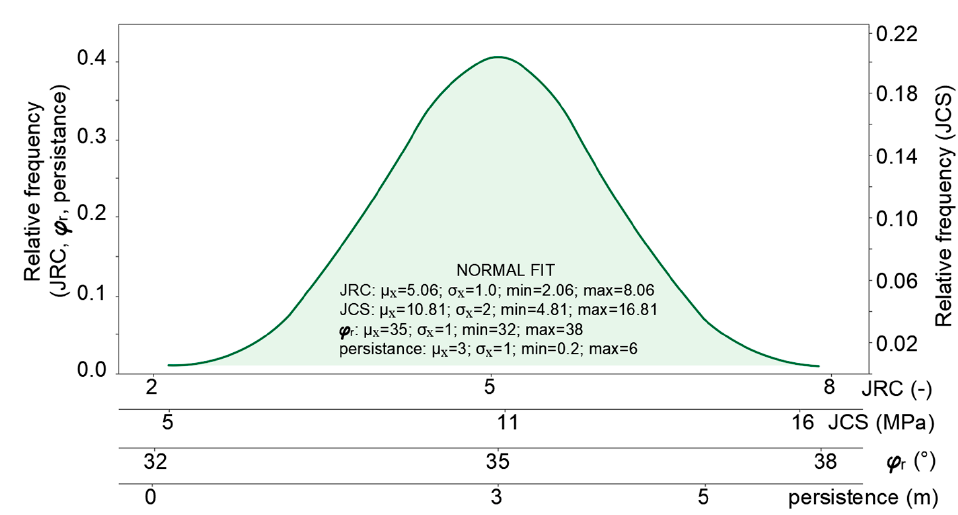
XX indicates azimuth value in degrees; XXX indicates dip direction angle in degrees; X a , X pu represent values of variation coefficient of azimuth and dip direction angle, respectively; minimum adopted value of persistence is 0.2 m.